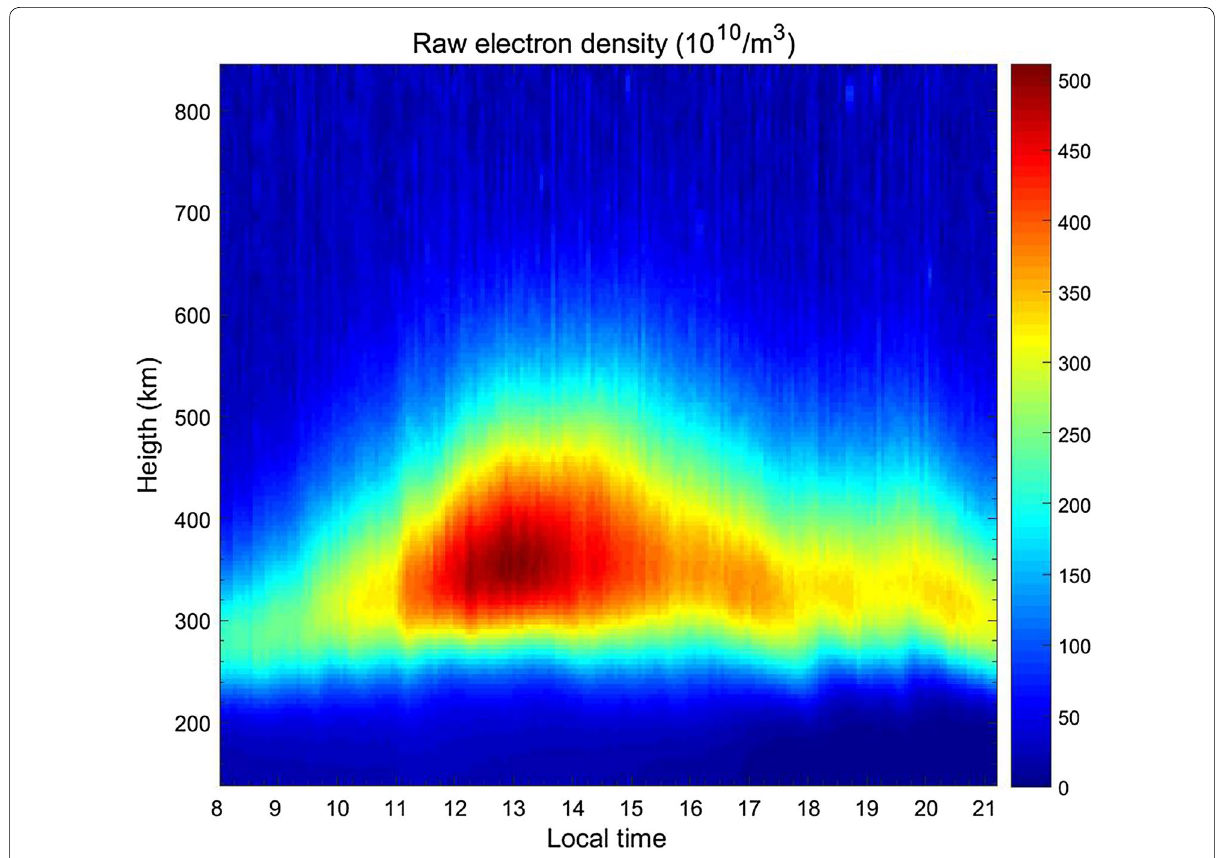
Fig. 11 Daily variation of raw electron density in November